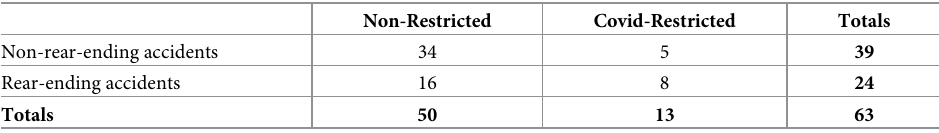
Table 5. GM cruise accident types during “Non-Restricted” vs “Covid-Restricted”